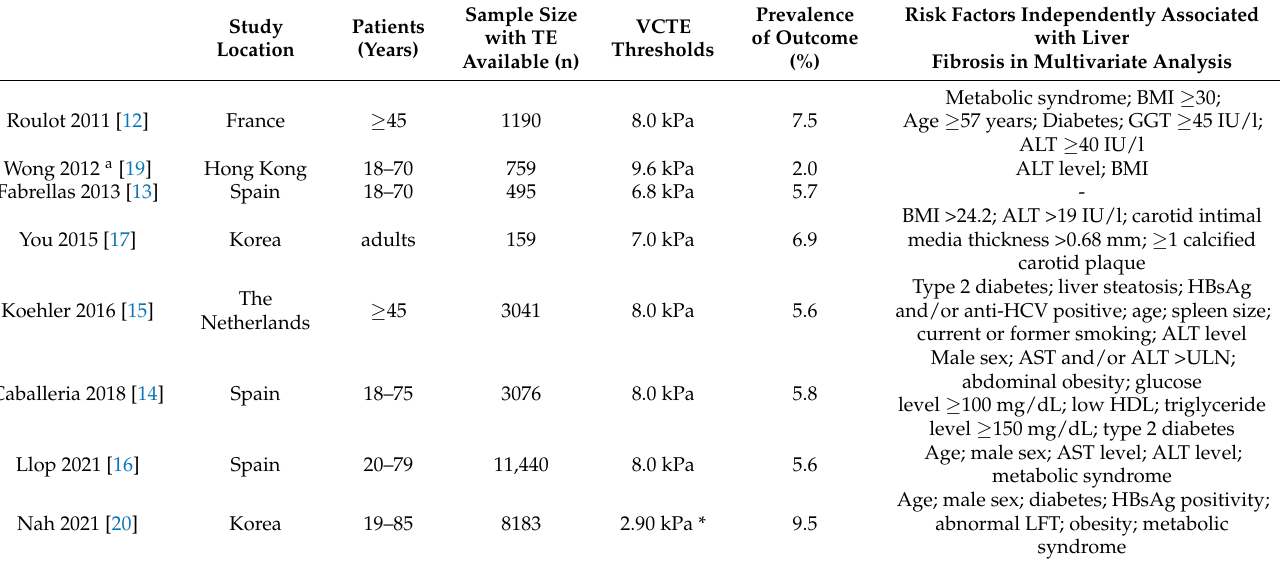
Table 1. Results of the studies reporting liver fibrosis prevalence in unselected participants with the use of transient elastography in a community